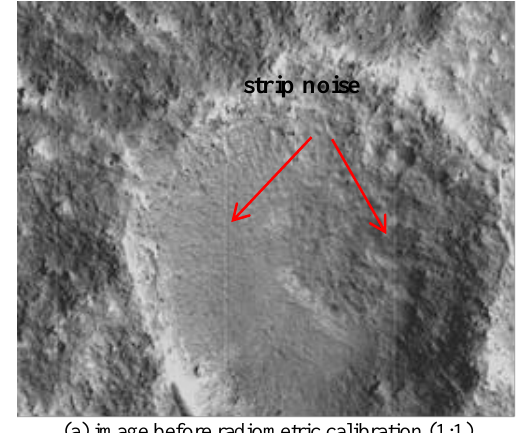
Figure 6. Mapping modular structural diagram